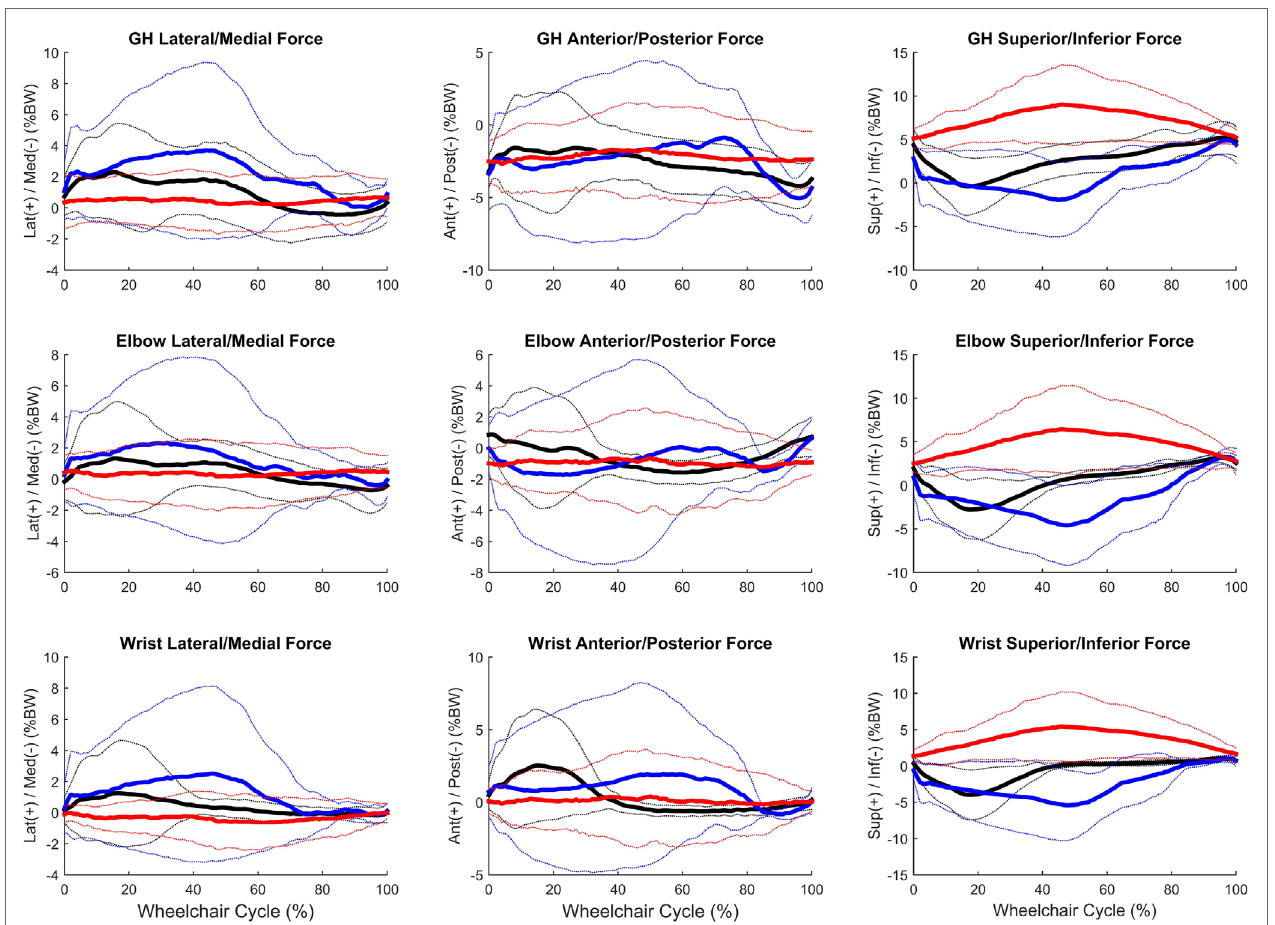
FigUre 8 | group mean (bold) and ± 1 sD for the glenohumeral joint forces (top row), elbow joint forces (middle row), and wrist joint forces (bottom row) during the steady-state propulsion (black), start stroke (blue), and stopping stroke (red) . All forces are normalized to percentage of body weight (%